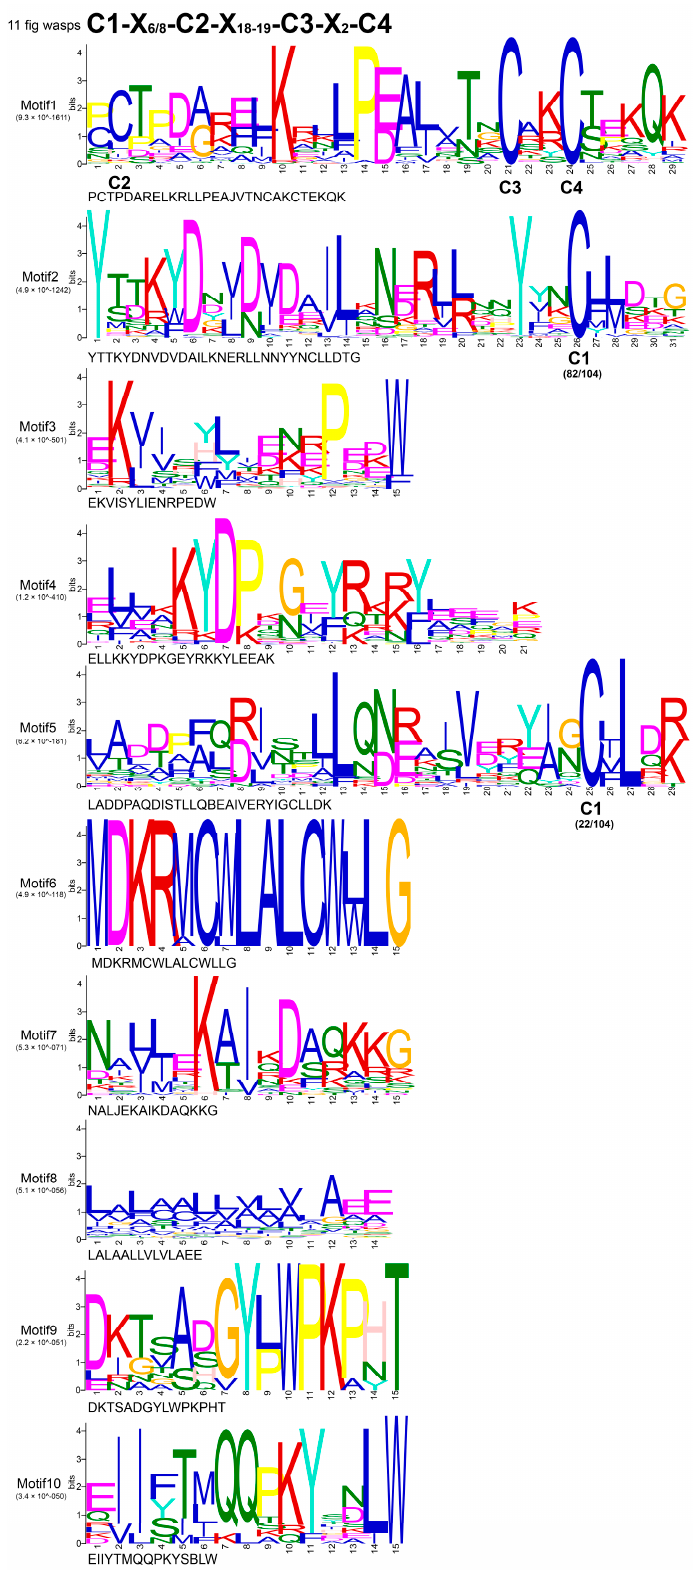
Figure 2. The 10 conserved motifs of 104 CSP genes in the 11 fig wasps. Four conserved cysteine residues (C1–C4) correspond to the corresponding positions of motifs. X 6 / 8 indicate six or eight non-cysteine amino acids; X 18-19 indicate 18 to 19 non-cysteine amino acids; X 2 indicate two non-cysteine amino